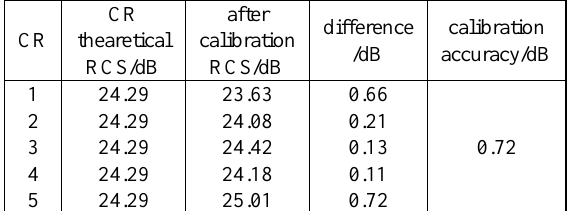
Table.4 Integral Method Calibration Constant Statistics Table